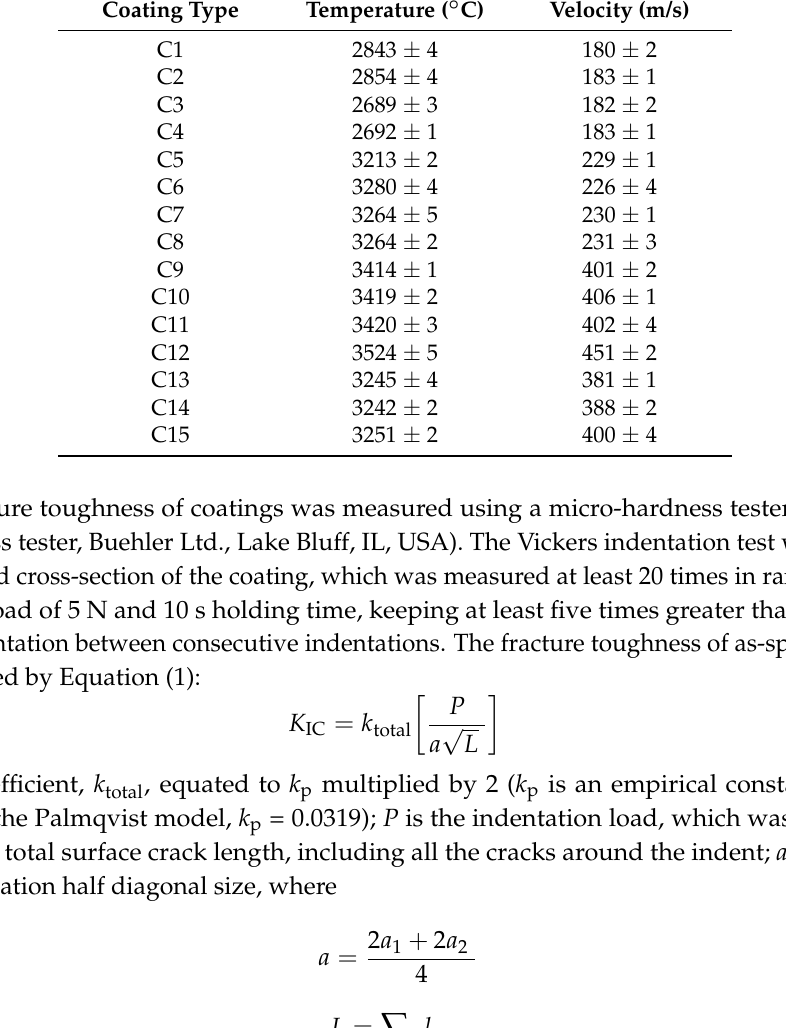
Table 2. Surface temperature and in-flight velocity of the fifteen kinds of coating particles [26]. Coating